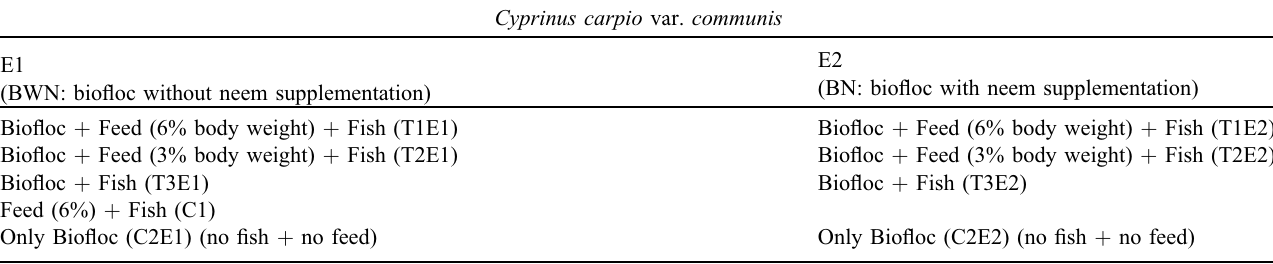
Table 1. Experimental design for the present study.